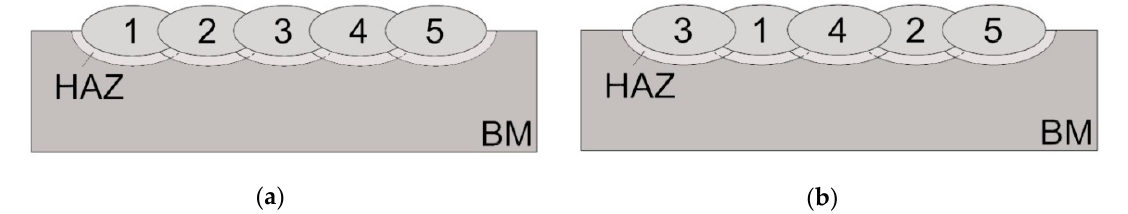
3 of 10 Figure 1. Wet welding by covered electrodes schema. 1: water vapor, 2: gas bubbles, 3: flux coating, 4: wire, 5: melting flux coating, 6: liquid metal, 7: electric arc, 8: base materials, 9: slag, 10: gas from melting flux coating. For the tests, 2 specimens were made in the water (0.15 m depth) with 5 beads in each. The time between welding each bead was 120 s. Specimens were welded by different techniques. In sample S1, the beads were laid one after the other from bead 1 to bead 5. In sample S2, the beads were not laid in order. These 2 techniques were chosen because they are representative of welding techniques. In S1, a bead was tempered only by the bead welded later. In S2, beads 1 and 2 were tempered by 2 beads. The use of other techniques, such as 14253, would obtain only one bead (bead 2), which will be tempered by 2 others. That may not have allowed preparation of the planned experiments. The schemas of welding techniques for S1 and S2 specimens are presented in Figure 2. The welding parameters were chosen according to preliminary tests. They provided stability of the welding arc in the experimental conditions and allowed heat input values higher than 0.90 kJ/mm. From the point of view of weldability in underwater conditions, these values may reduce the susceptibility to cold